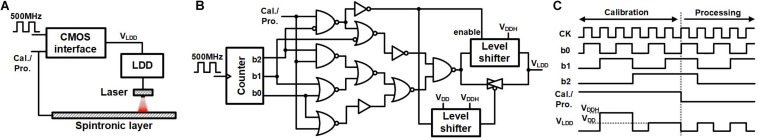
(A) The block diagram of the proposed LAS-NCS including CMOS interfacing block, VCSEL array, LDD, and the spintronic layer. (B) CMOS interfacing circuit design. (C) Timing diagram of the CMOS interfacing block.